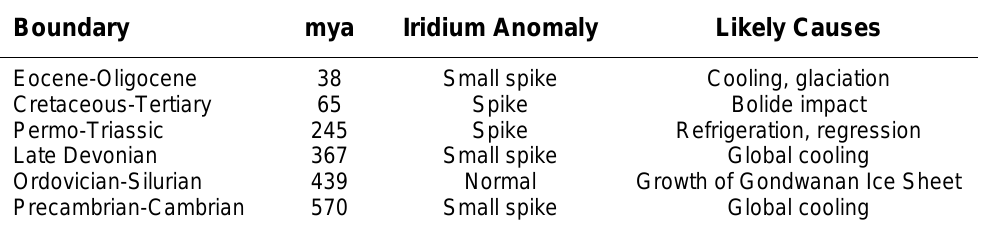
Mass Extinctions and Correlations with Iridium Levels and Climate